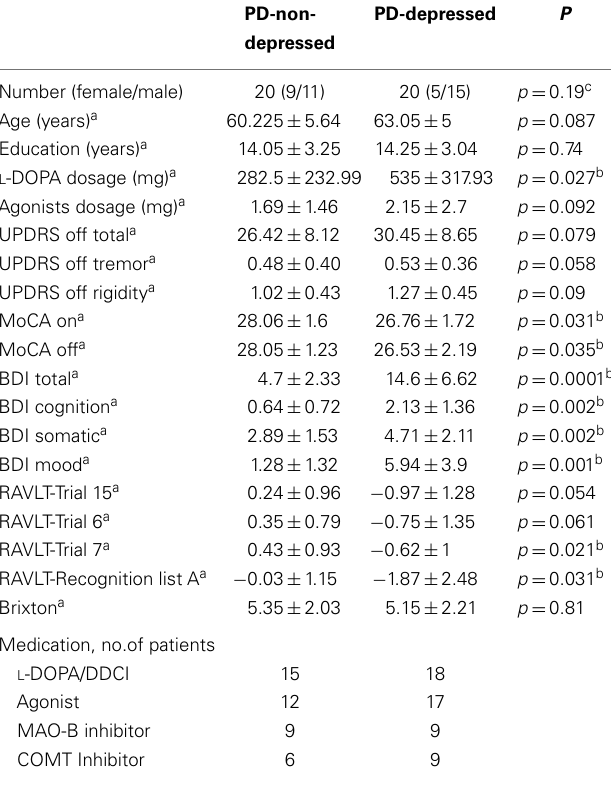
Table 1 | Demographic data for patients with Parkinson’s disease (PD)